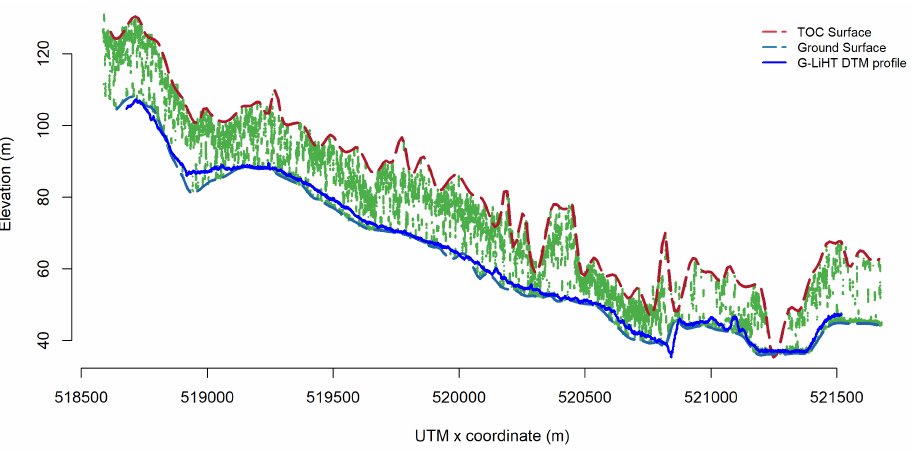
Figure 7. The result of the moving profiling method to match the SIMPL and G-LiHT